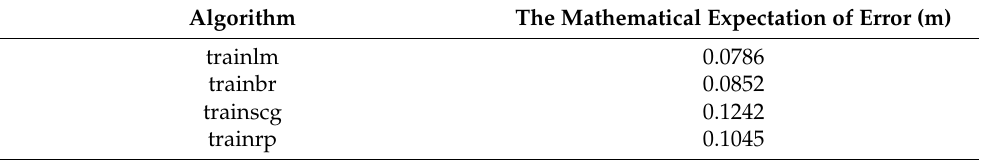
Figure 9. Error histogram as the difference between the target and predicted values when training a neural network using: ( a ) the Levenberg–Marquardt (trainlm); ( b ) the Bayesian regularization backpropagation (trainbr); ( c ) scaled conjugate backpropagation gradient (trainscg); ( d ) resilient backpropagation (trainrp). Table 3. Mathematical expectations of NN training